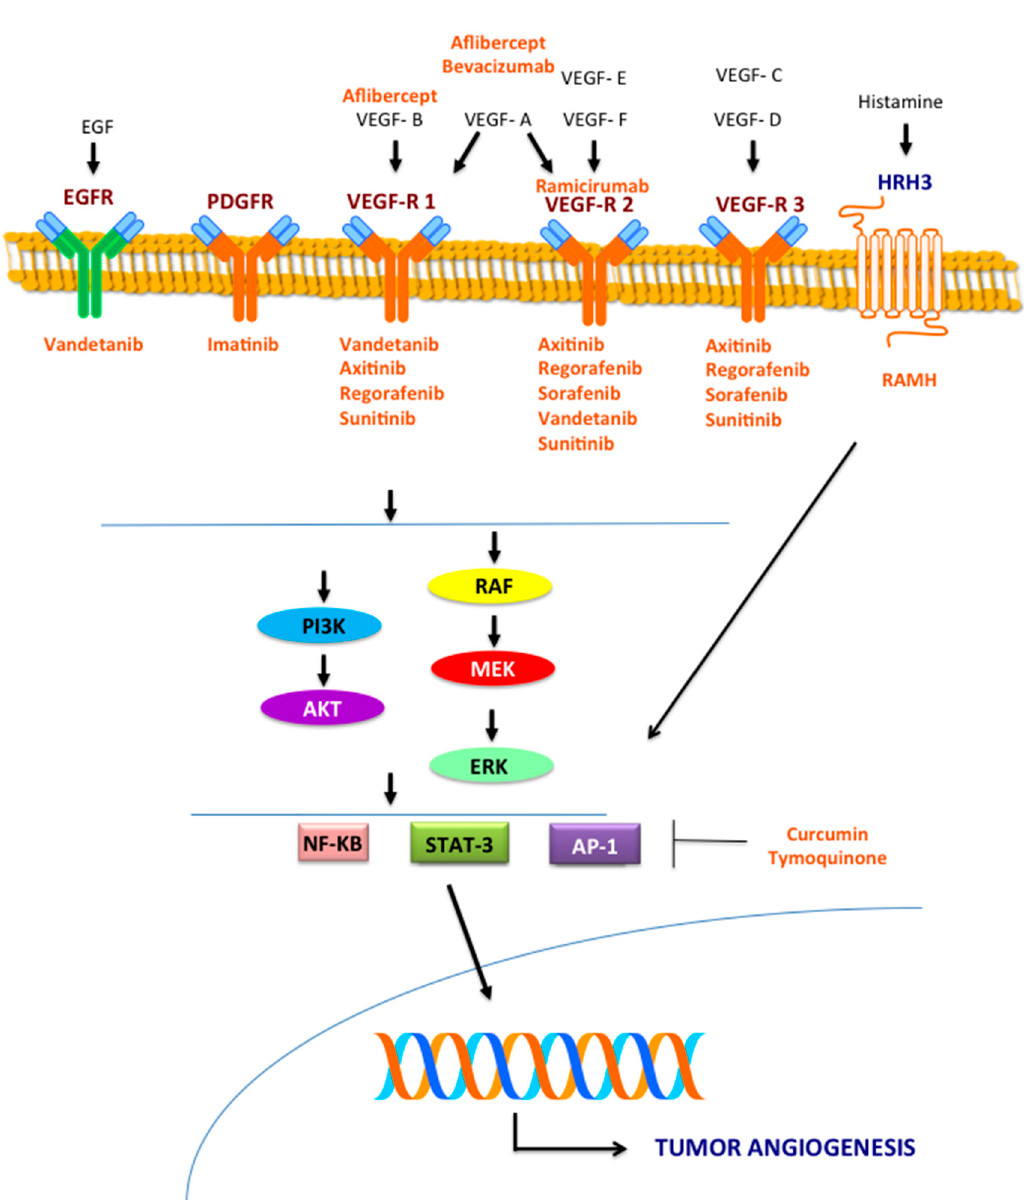
Figure 1. Mechanisms involved in the angiogenic process and the potential therapeutic role of drugs targeting the pro-angiogenic signaling pathways in tumors of the biliary tract.